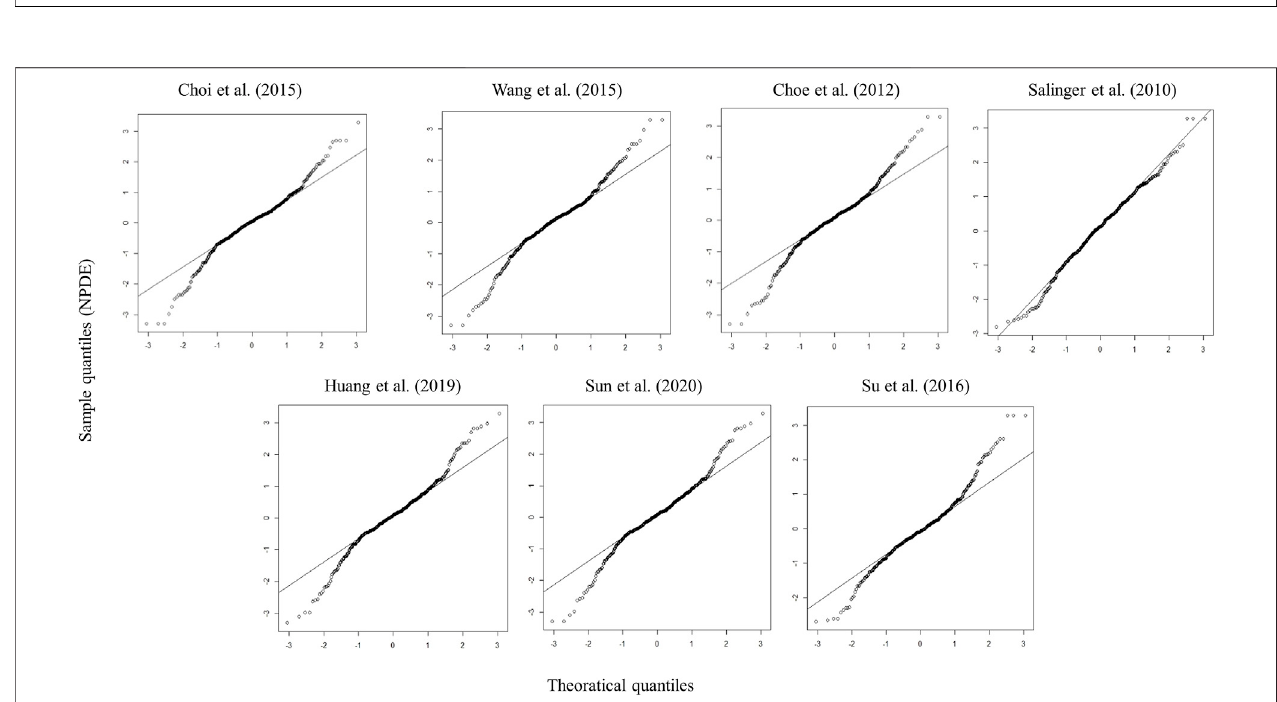
FIGURE 2 | Quantile – quantile plots (the distribution of the NPDE against theoretical distribution) of seven published population pharmacokinetic models (Salinger et al., 2010; Choe et al., 2012; Choi et al., 2015; Wang et al., 2015; Su et al., 2016; Huang et al., 2019; Sun et al., 2020).